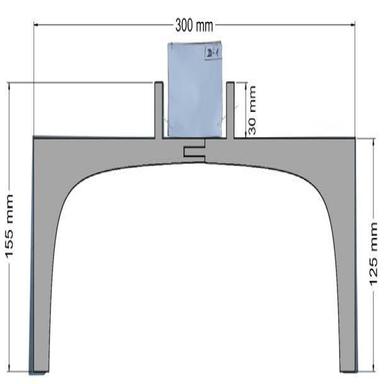
Relative range measurements of four textiles in comparison to Pb, Al, and only water (i.e. empty). The proton range is defined at the 80% fall-off behind the Bragg peak. Details on the space suit materials are listed in.